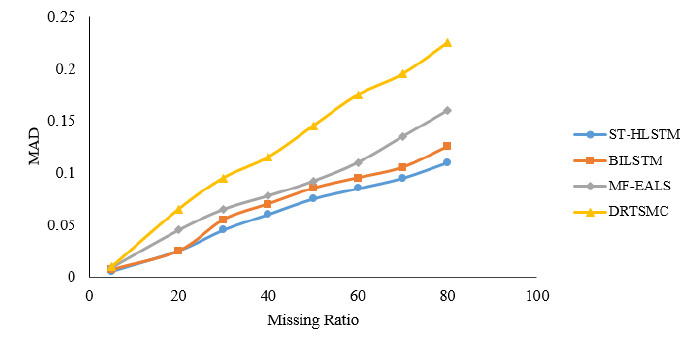
Figure 4. Mean Absolute Deviation for different evaluation methods.